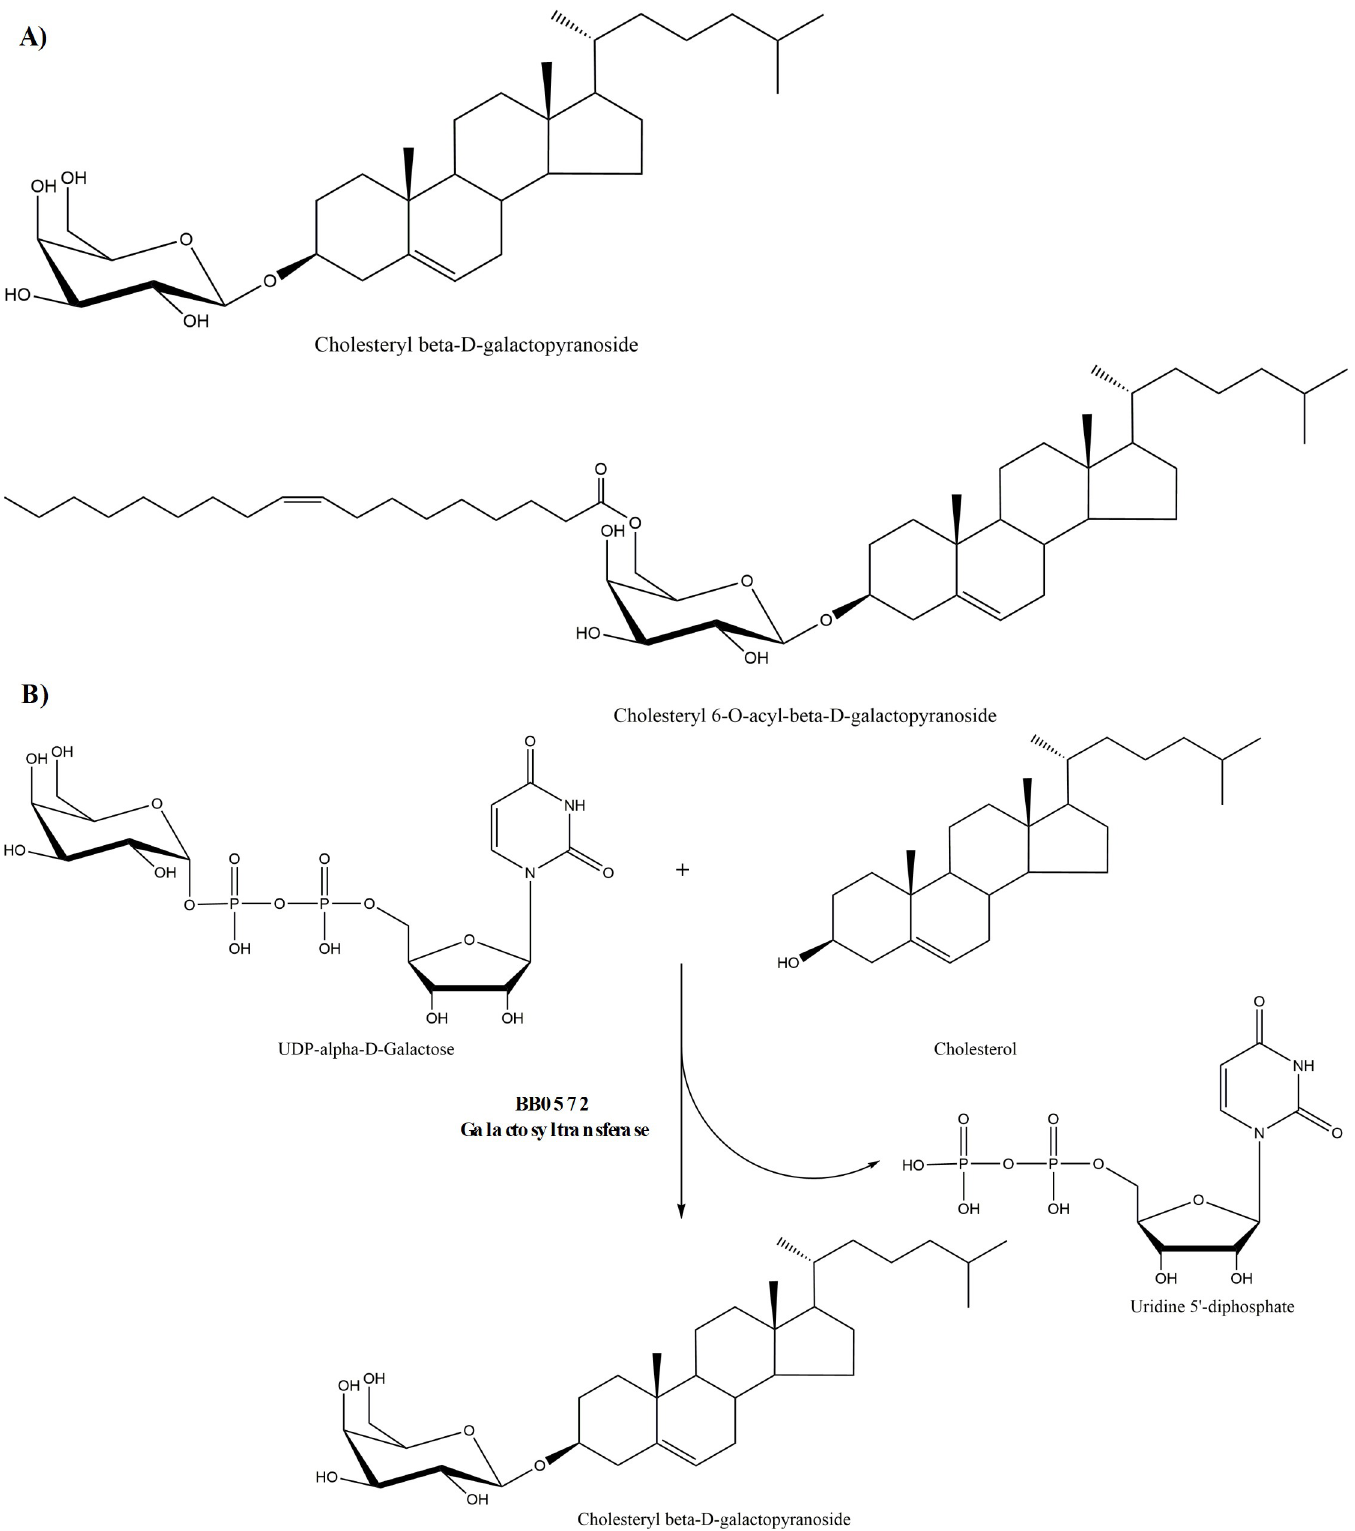
Fig 1. The cholesterol glycolipids of Borrelia burgdorferi and predicted reaction. A. Chemical structure of cholesteryl- β -D-galacto-pyranoside (CGal); and cholesteryl 6-O-acyl- β -D-galactopyranoside (ACGal) B . Predicted reaction showing UDP-alpha-galactose as the sugar donor and cholesterol as the acceptor molecule to yield cholesteryl β -D-galactopyranoside (CGal) which possess a galactosyl residue with its anomeric bond in the β - configuration.